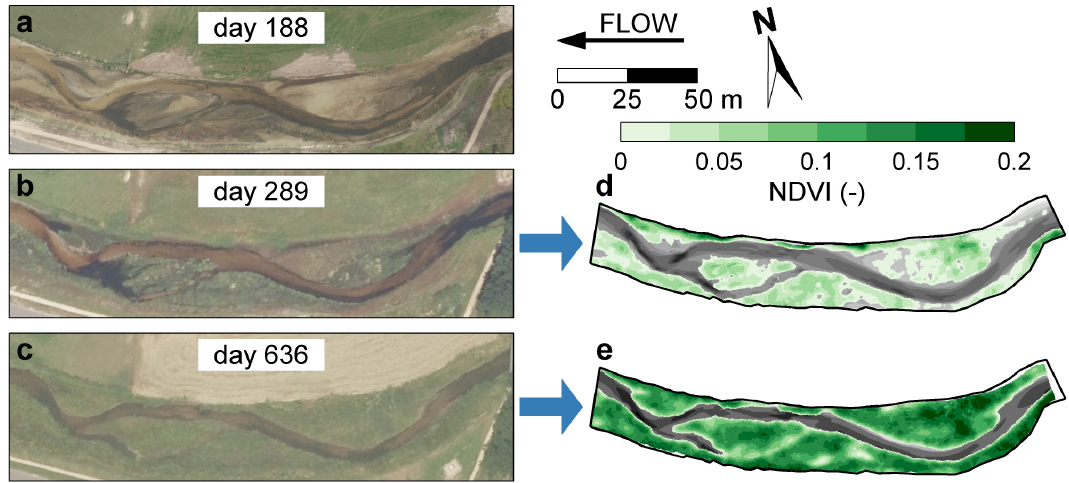
Figure 8. Three aerial photographs taken on (a) day 188 (April 2012), (b) day 289 (July 2012) and (c) day 636 (July 2013); (d) and (e) show positive NDVI values derived from the aerial photographs from (b) and (c) , respectively. The DEMs from survey 6 (d) and survey 13 (e) are shown in greyscale as a reference.